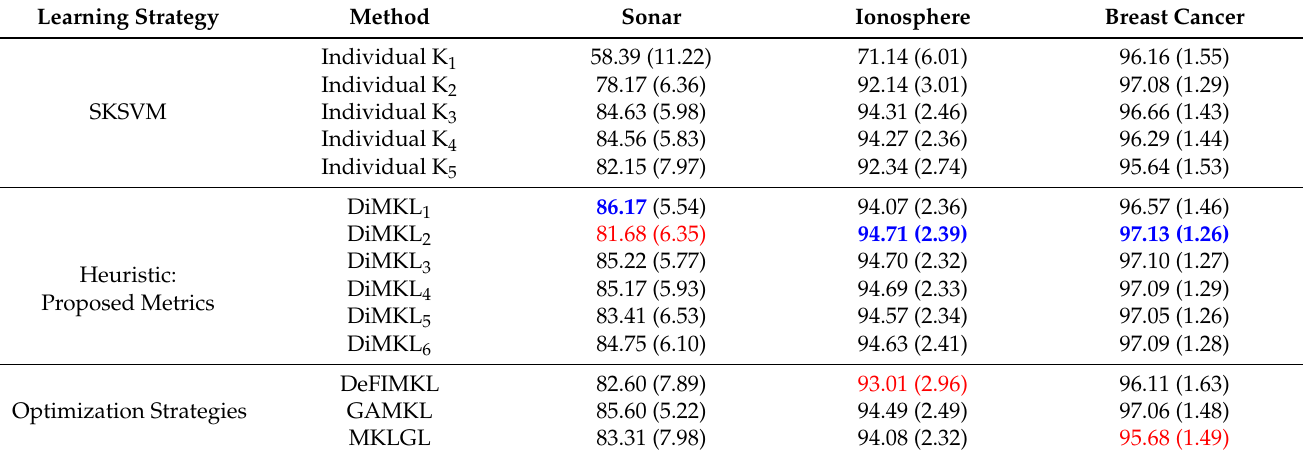
Table 6. Classification accuracy and standard deviation for 100 trials on UCI benchmark datasets. Note: 80% training, 20% testing. Highest performing method is shown in blue; lowest performing is shown in